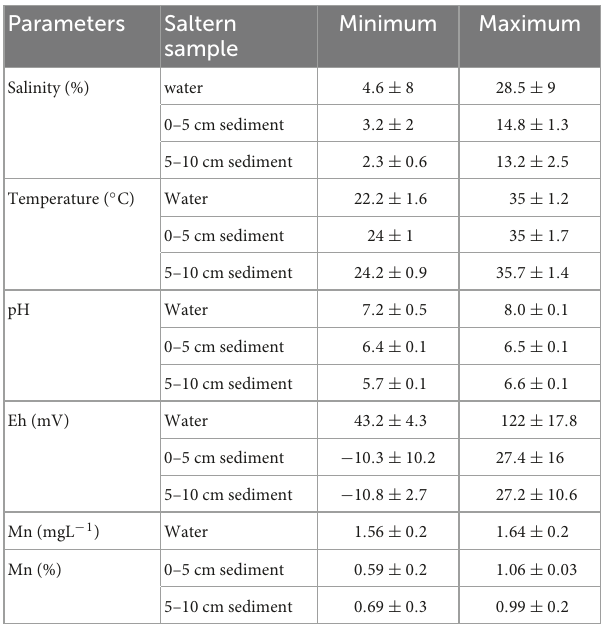
TABLE 1 Physico-chemical parameters during the salt-making season (Mean ± S.D).